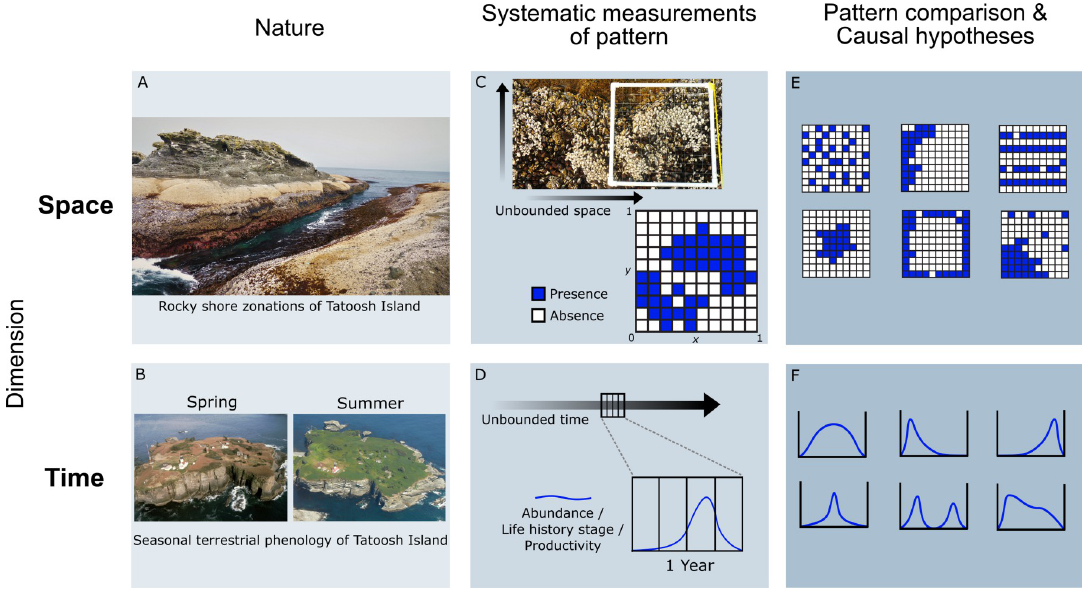
Fig 1. Distribution patterns in finite units of space or time. (A) Repeated patterns across space are often innately obvious to human observers, such as the zonation of rocky shore intertidal communities, even if space in nature is realistically messy and unbounded. (B) Repeated patterns in time, such as seasonal phenology, can be seen over longer observations. (C) Patterns can only be defined and quantitatively measured given finite boundaries. In space, standardized delineations such as transects and grids are commonplace. (D) Just as in space, one must delineate unbounded time into relevant units such as years or climatic growing seasons to quantify time points occupied by phenological expression. (E) Only within standardized arenas of measurement are comparative studies possible and can eco-evolutionary theories of change be developed and tested. (F) Similarly, an explicit view of timing patterns within standardized time windows sets the basis for systematic hypotheses of how phenology is shaped by ecological and evolutionary forces. Photo: J. Timothy